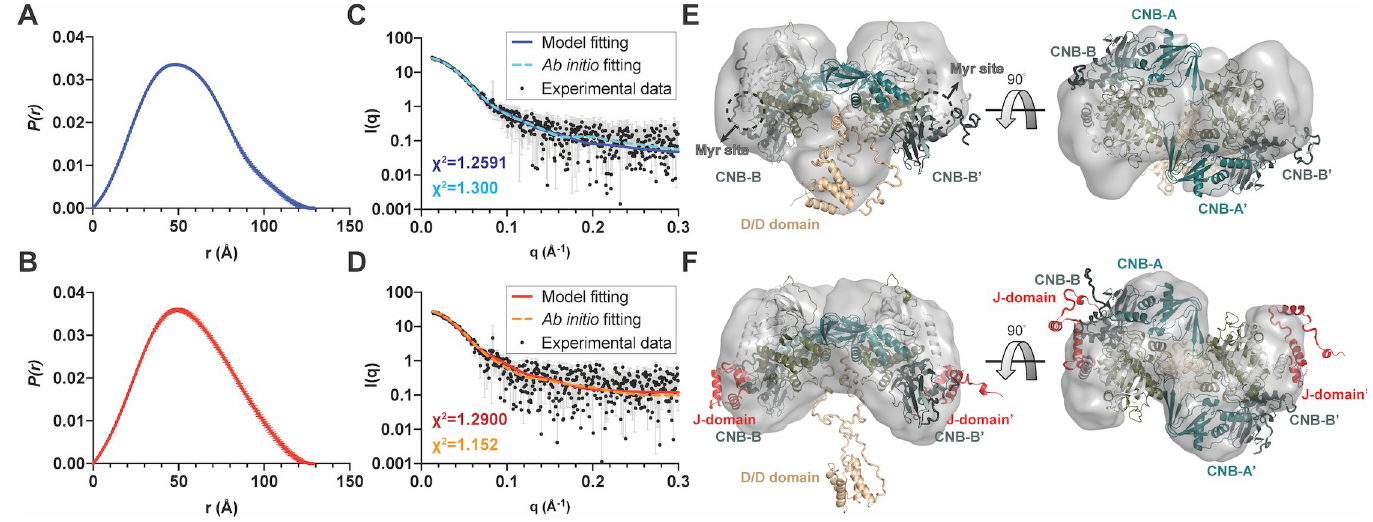
Fig 4. SAXS analyses of RII β 2 C 2 and RII β 2 J-C 2 holoenzymes. ( A, B ) P (r) functions of RII β 2 C 2 (A) and RII β 2 J-C 2 (B) holoenzymes. ( C, D ) Scattering plots, atomic structure, and ab initio models fittings of RII β 2 C 2 holoenzyme (C) with χ 2 = 1.2591 (atomic structure) and χ 2 = 1.300 (ab initio) and RII β 2 J-C 2 holoenzyme (D) with χ 2 = 1.2900 (atomic structure) and χ 2 = 1.152 (ab initio). ( E, F ) The SAXS atomic structure models of RII β 2 C 2 (E) and RII β 2 J-C 2 holoenzymes (F) overlay with ab initio envelopes. The data used to make these figures can be found in S1 Data. CNB, cyclic nucleotide binding; SAXS, small-angle X-ray scattering.